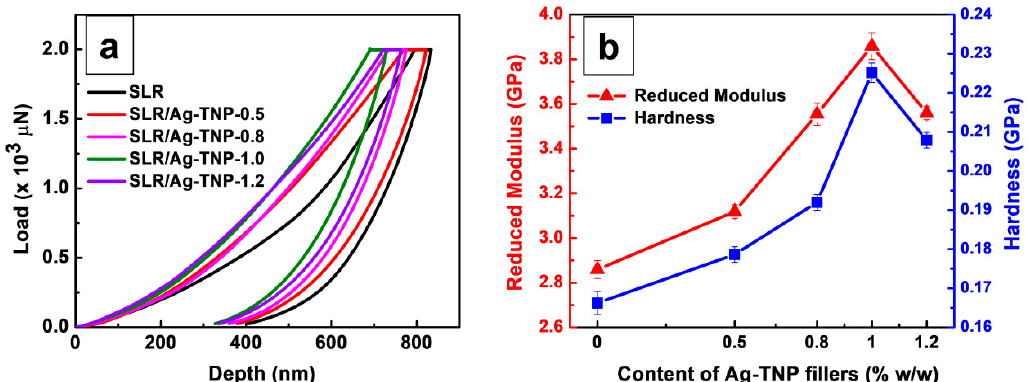
Figure 8. The nanoindentation analysis of neat SLR and SLR / Ag-TNP nanocomposites ( a ) the indentation load–depth curves for neat SLR and SLR / Ag-TNP nanocomposites with respect to di ff erent concentrations, ( b ) the observed variation of hardness (blue patterns) and reduced modulus (red patterns) of the SLR / Ag-TNP nanocomposites, where Ag-TNP content used as in % w / w of 0, 0.5, 0.8, 1.0, and 1.2. Table 3. Extracted results of pure SLR and SLR / AgTiO 2 nanocomposites from the nanoindentation analysis.